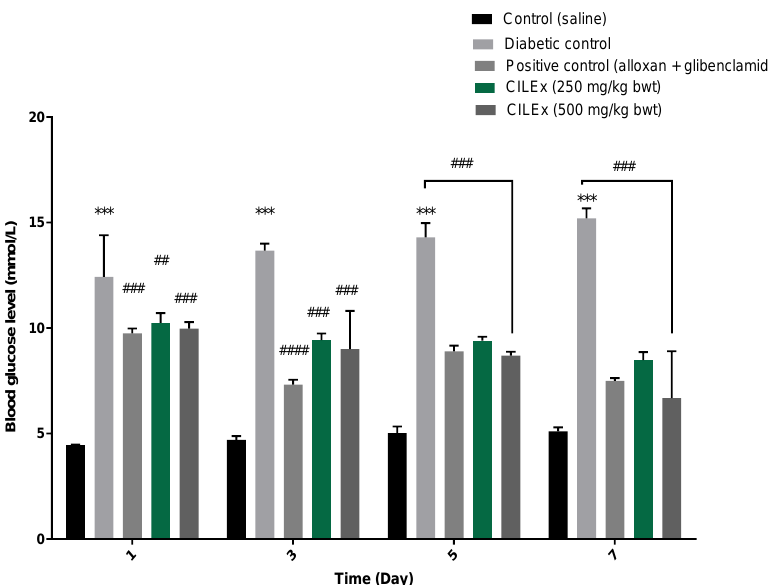
Figure 2. Effect of CILEx on blood glucose levels after a 7-day treatment. Glibenclamide was used as a positive control. The values are represented as mean ± SEM; n = 4, significant difference ( p < 0.05) was calculated as compared to the untreated diabetic control group. In the figure, (***) over the bar denotes significant different from control, and (##, ###, ####) indicates significant difference from diabetic control.